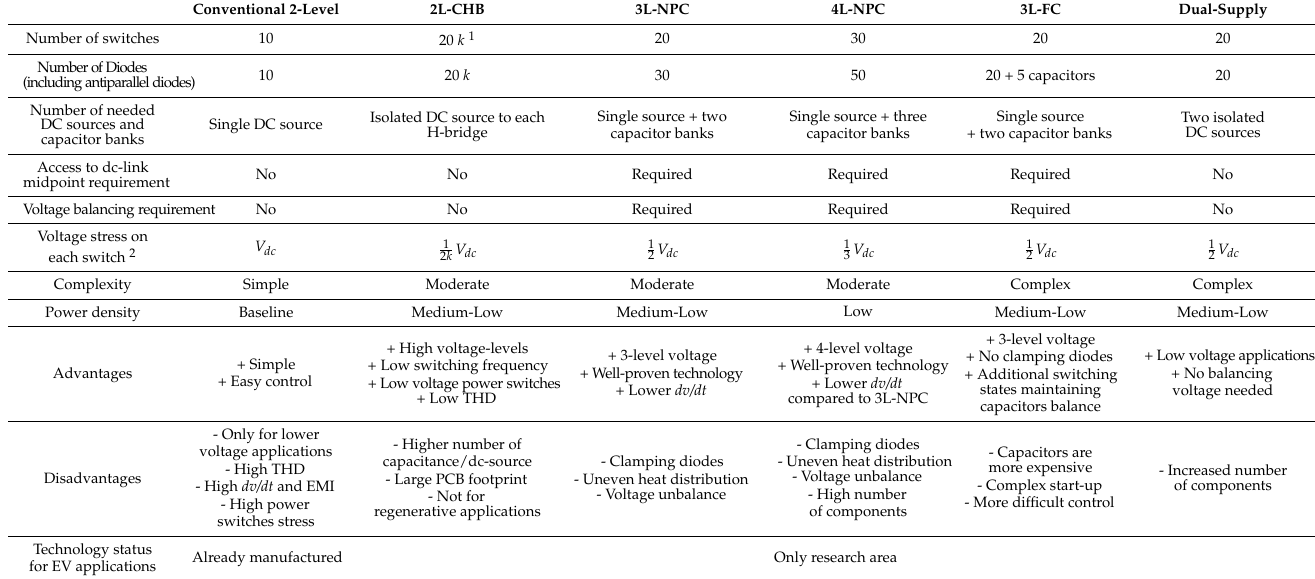
Table 2. Comparison between different converter topologies for five-phase